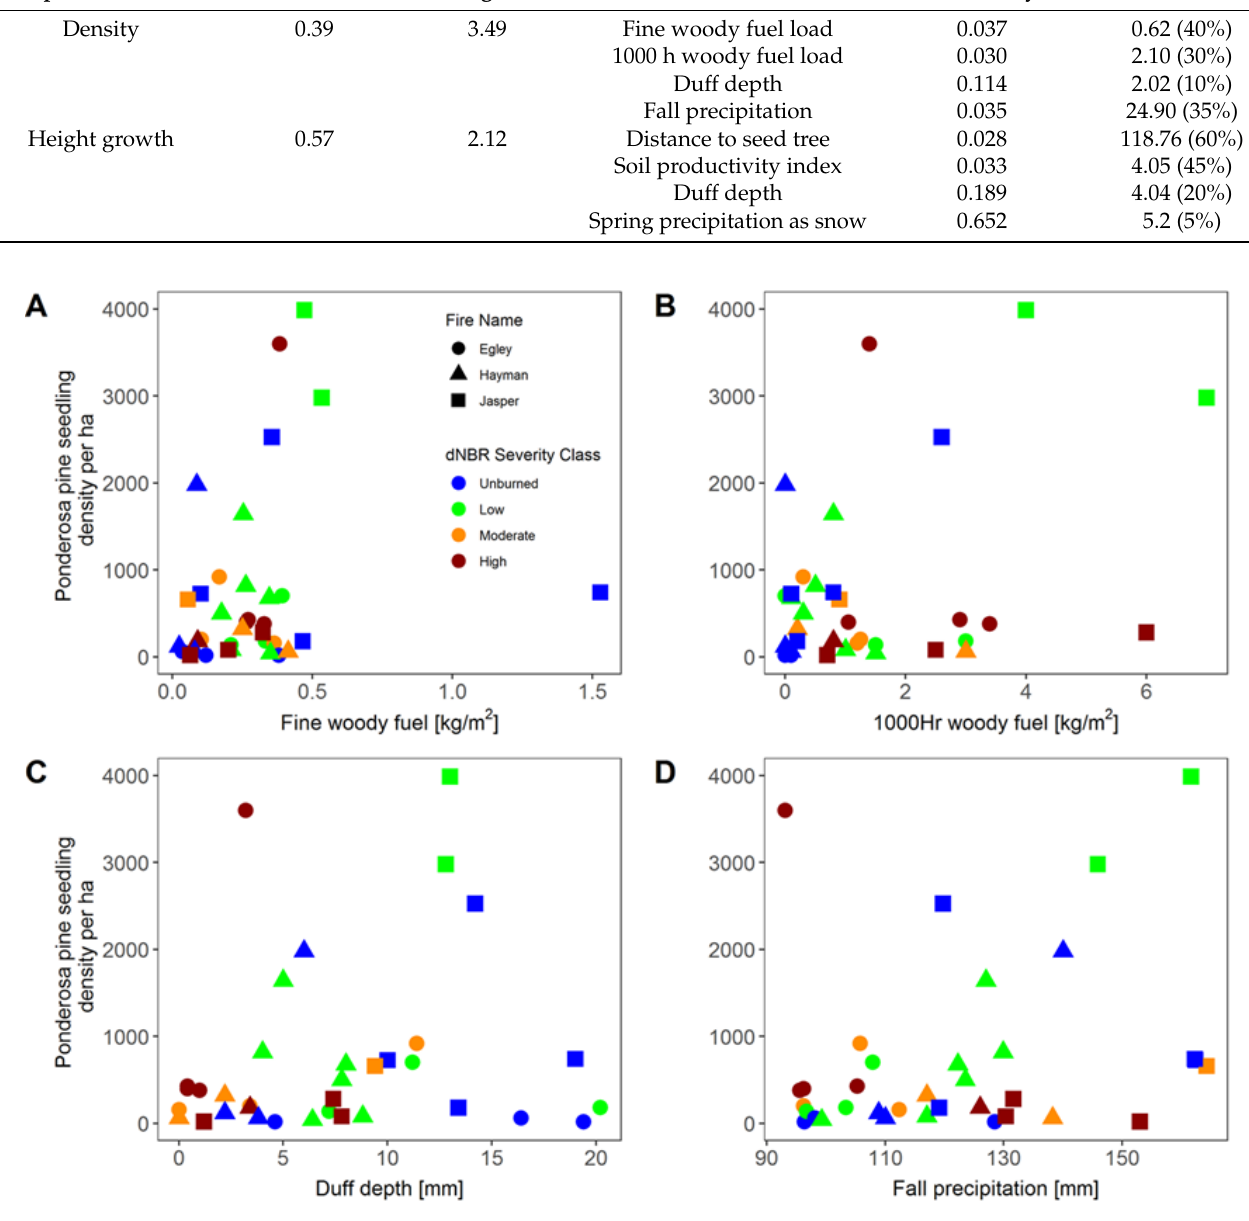
Figure 1. Predictors from best-fit non-parametric multiplicative regression (NPMR) model (see Table 2) for ponderosa pine seedling density across burn severity classes following three large wildfires. Predictors are ( A ) fine downed woody fuel load, ( B ) 1000-hr downed woody fuel load, ( C ) duff depth, and ( D ) fall precipitation.